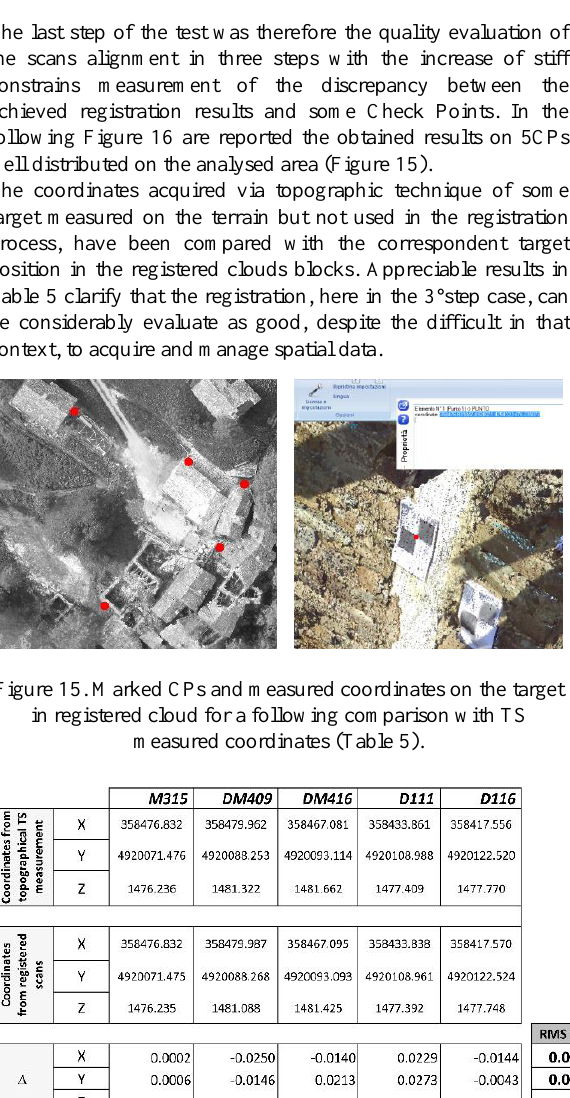
Figure 11. Position of GCP measured by GPS techniques used as further constrain in terrestrial scans registration